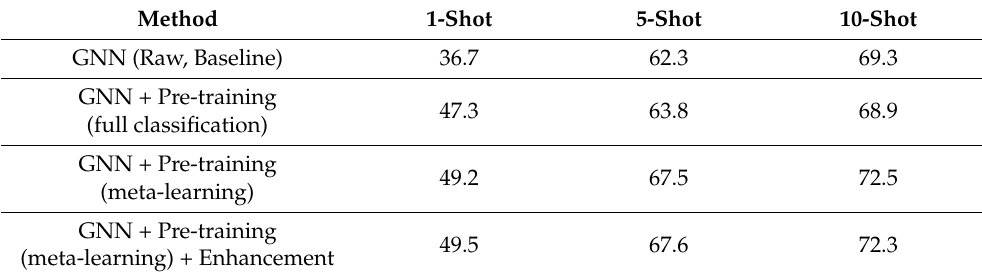
Table 3. Classification accuracies (%) with different pre-training methods in the 5-way K-shot cases.